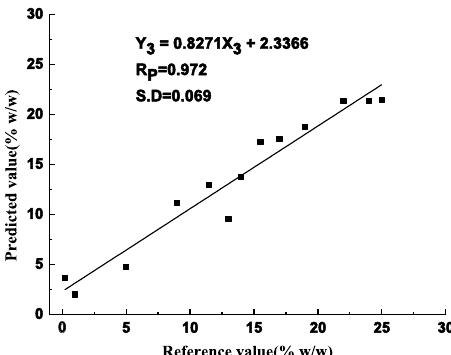
Fig. 6. Relationship of predicted values with the reference values of omethoate solutions by PLS with MSC. The straight line is obtained by linear regression.